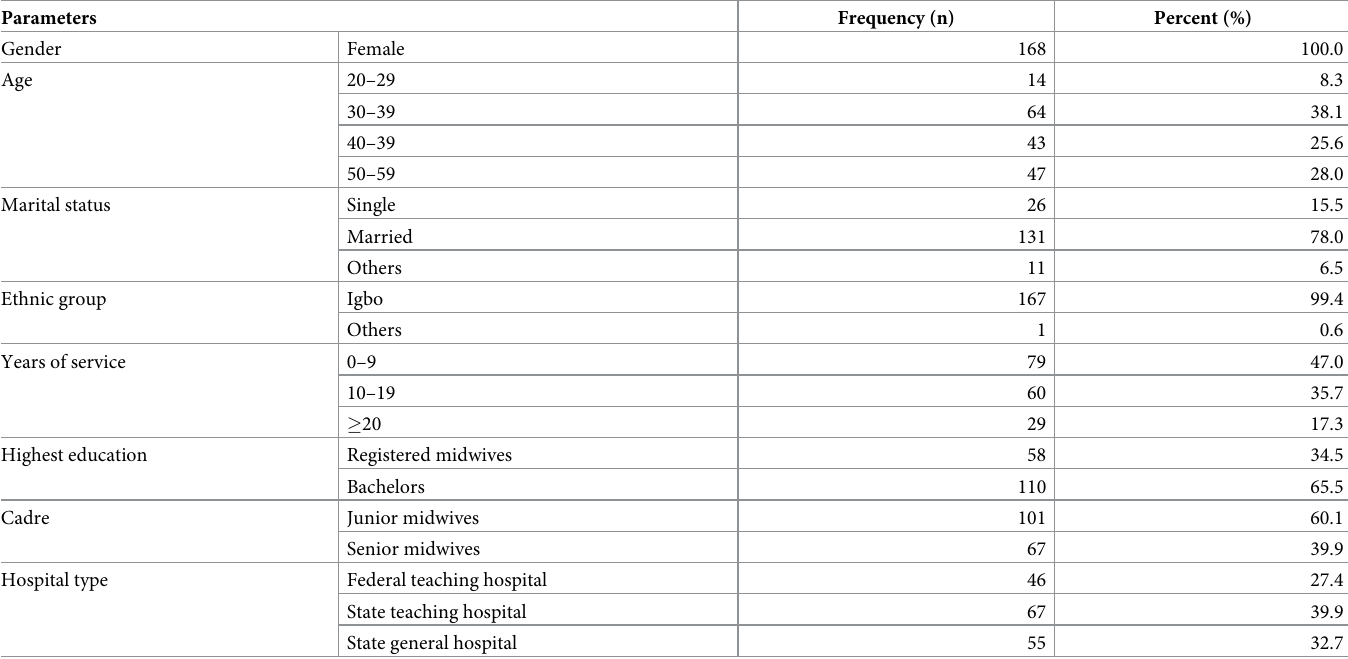
Table 1. Basic characteristics of study survey respondents.